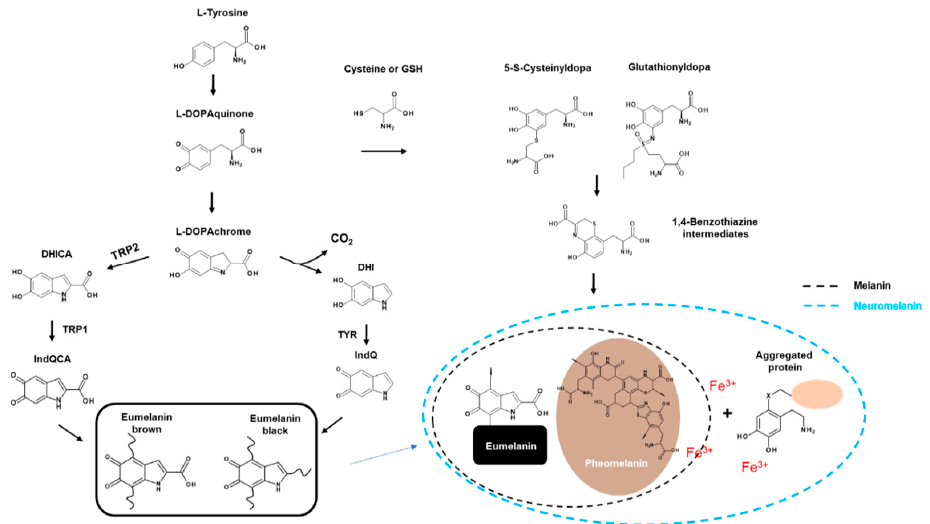
Figure 1. Biosynthesis of melanin.